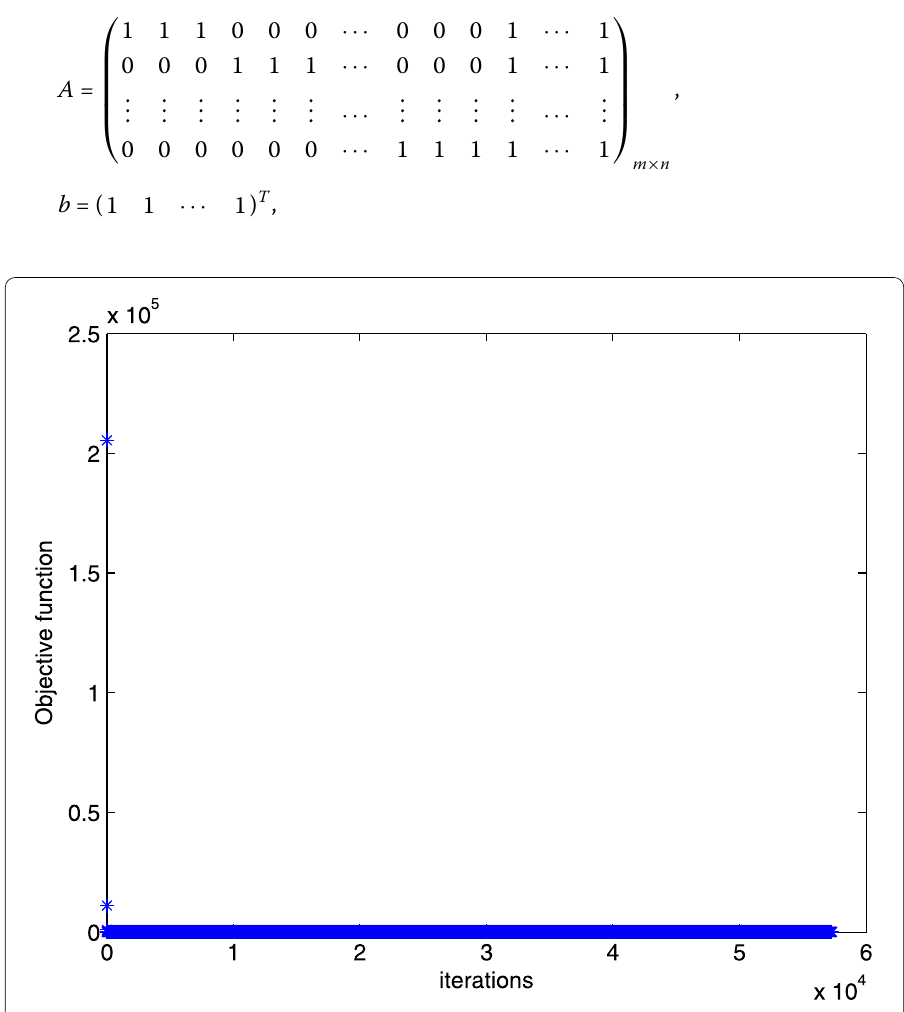
Figure 1 Numerical results for solving Example 1 with Algorithm